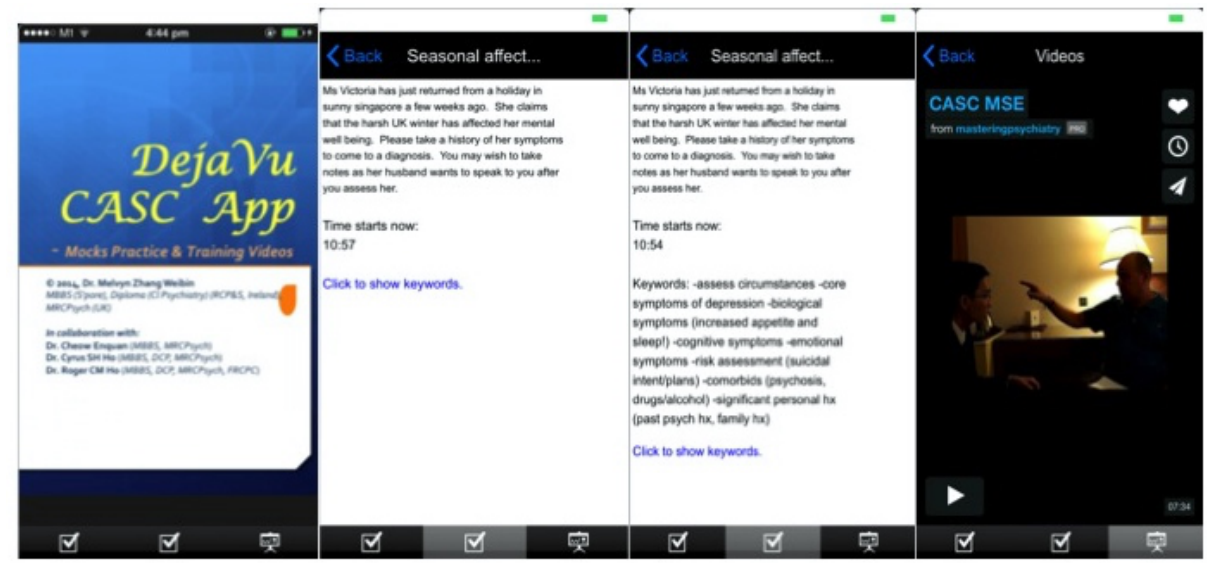
Figure 2. Overview of the